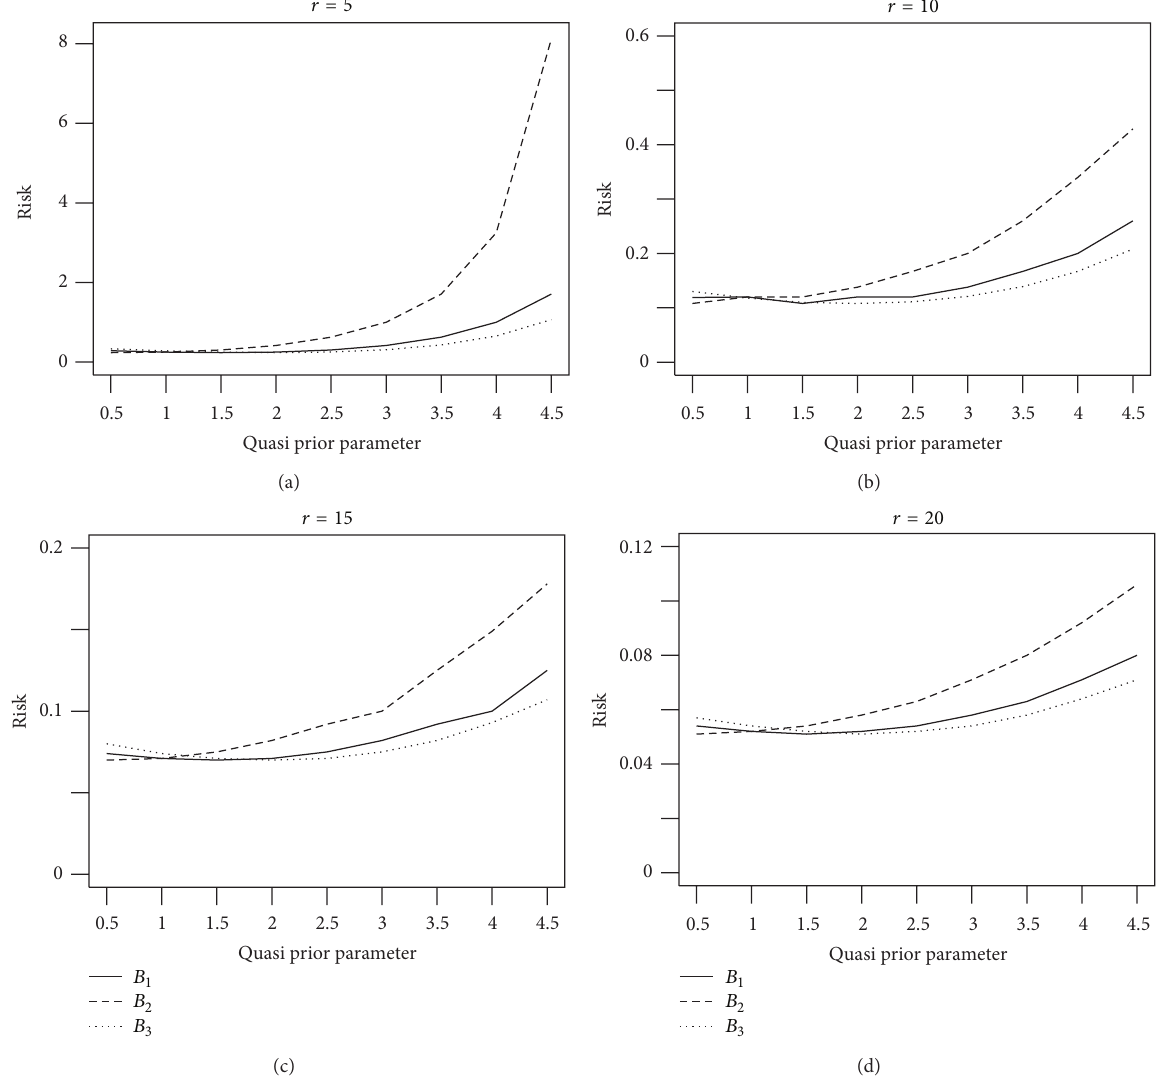
Figure 2: The evolution of risk ratio to 𝛼 when 𝑟 = 5, 10,15 , and 20 .